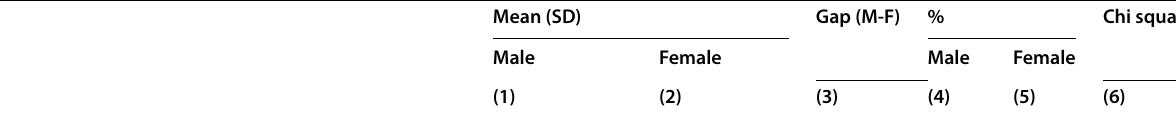
Table 2 Descriptive statistics of variables used in the